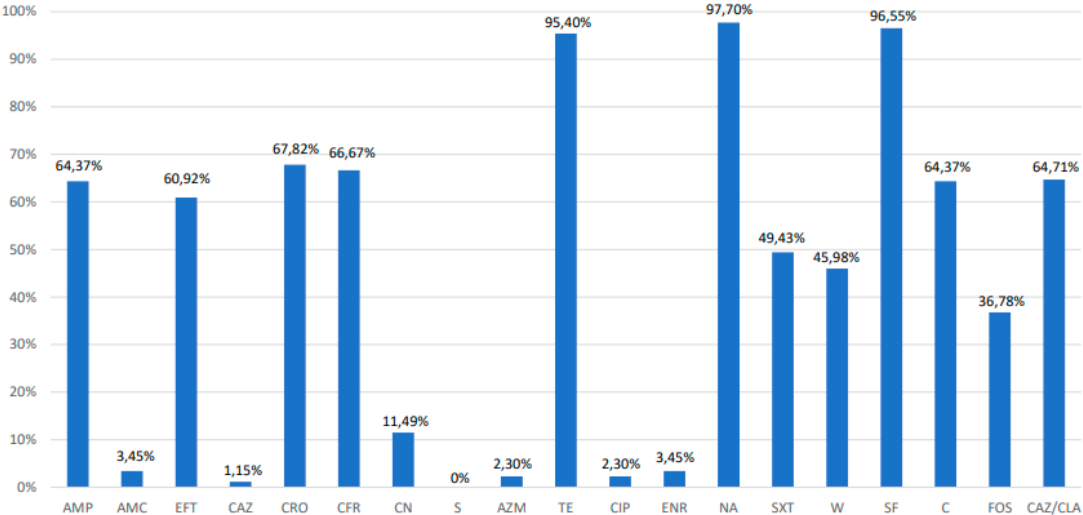
Figure 1. Percentages (%) of antimicrobial resistant Salmonella Enterica ser. Infantis. AMP, Ampicilin; AMC, Amoxicilin + Clavulanic Acid; EFT, Ceftiofur; CAZ, Ceftazidime; CRO, Ceftriaxone; CFR,